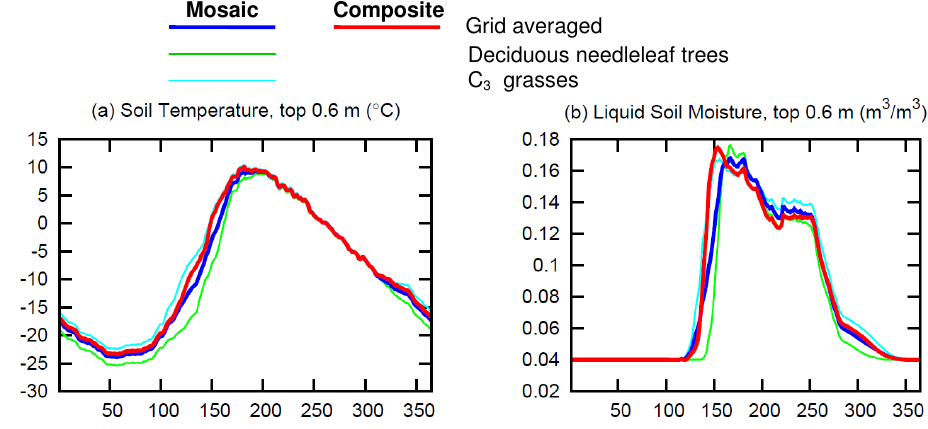
Figure 3. Simulated daily average values of (a) soil temperature and (b) soil moisture for the Siberia location. The blue and red lines represent grid-averaged values for the mosaic and composite approaches, respectively. The green and cyan lines represent values for the deciduous needleleaf tree and C 3 grass mosaic tiles in the mosaic approach, respectively.